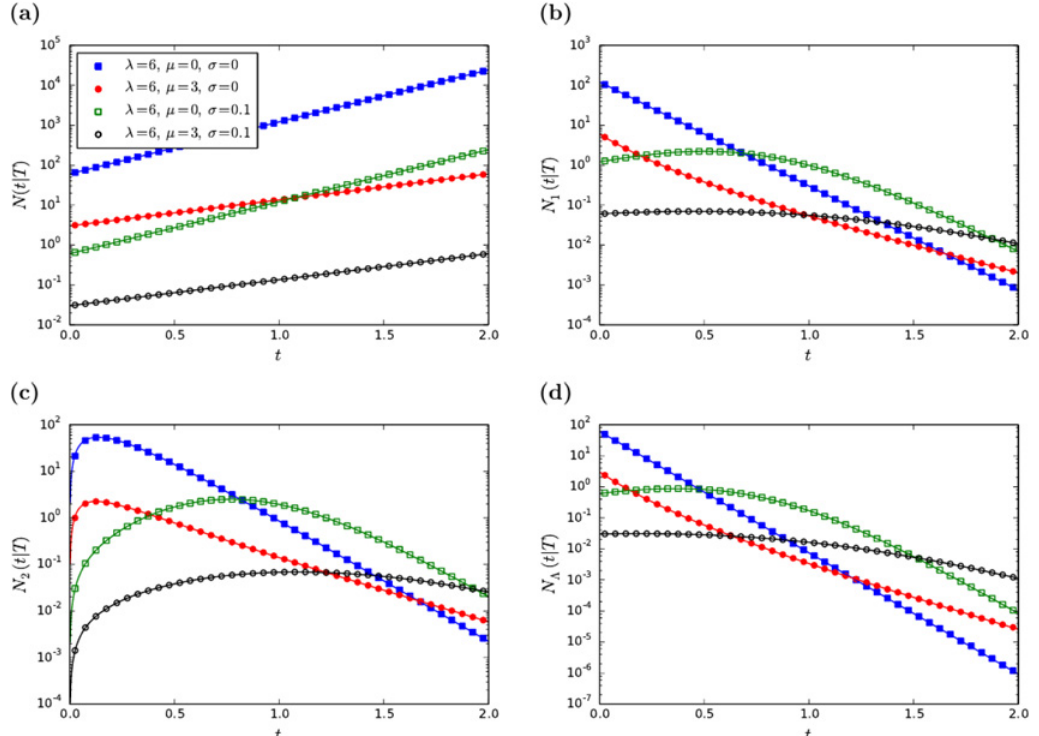
Fig 3. Comparison of the analytic results with numerical simulations. Markers indicate numerically obtained data using the following parameters set. T = 1, λ = 6, μ = 0 or 3 (circles or squares) and σ = 1 or 0.1 (empty or filled symbols). Lines represent the analytic formulas. (a) Density of number of pairs separated by a certain time, t . Lines were obtained using Equation (14). (b) Density of number of leaves separated by a certain time, t with their closest leaf. Lines were obtained using Equation (17) or Equation (20) with n = 1. (c) Density of number of leaves separated by a certain time, t with their next-closest leaf. Lines were obtained using Equation (33) or Equation (20) with n = 2. (d) Density of number of cherries separated by a certain time, t . Lines were obtained using Equation